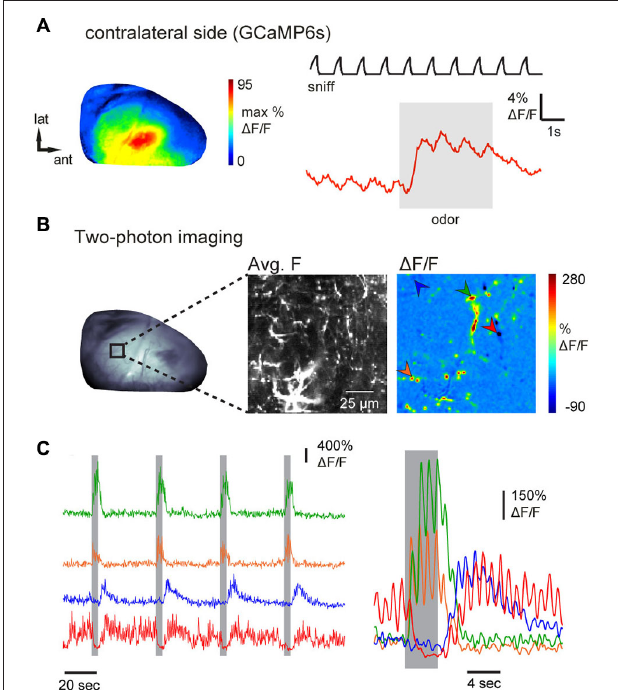
FIGURE 6 | Inhalation-driven and odorant-specific centrifugal AON inputs to the contralateral OB. (A) Response map (left) and time-course (right) of odorant-evoked (1% ethyl butyrate) GCaMP6s signals imaged from AON terminals in the contralateral dorsal OB of an anesthetized mouse, displayed as in Figure 2 . As with ipsilateral signals, contralateral AON input responses were driven by inhalation and broadly distributed across the dorsal OB. (B) Contralateral AON inputs imaged with two-photon microscopy in an anesthetized mouse. Left: epifluorescence image of the dorsal OB. Middle: Two-photon images showing resting GCaMP6s fluorescence (average fluorescence map) in AON axons in the indicated region. Right: Odorant-evoked response map showing strong fluorescence changes in small, sparsely-distributed foci likely corresponding to individual axonal fibers and varicosities. Arrowheads indicate foci used for the time-courses shown in (C) . (C) Traces demonstrating diverse responses of different contralateral AON inputs. Left traces show continuous fluorescence signals taken from the regions indicated in (B) during four consecutive odorant presentations. Right traces show the same responses averaged across eight trials. Fluctuations indicate inhalation-driven fluorescence increases (sniff trace not shown). Responses were consistent across trials and included “off” responses (blue trace) as well as suppression of ongoing activity (red